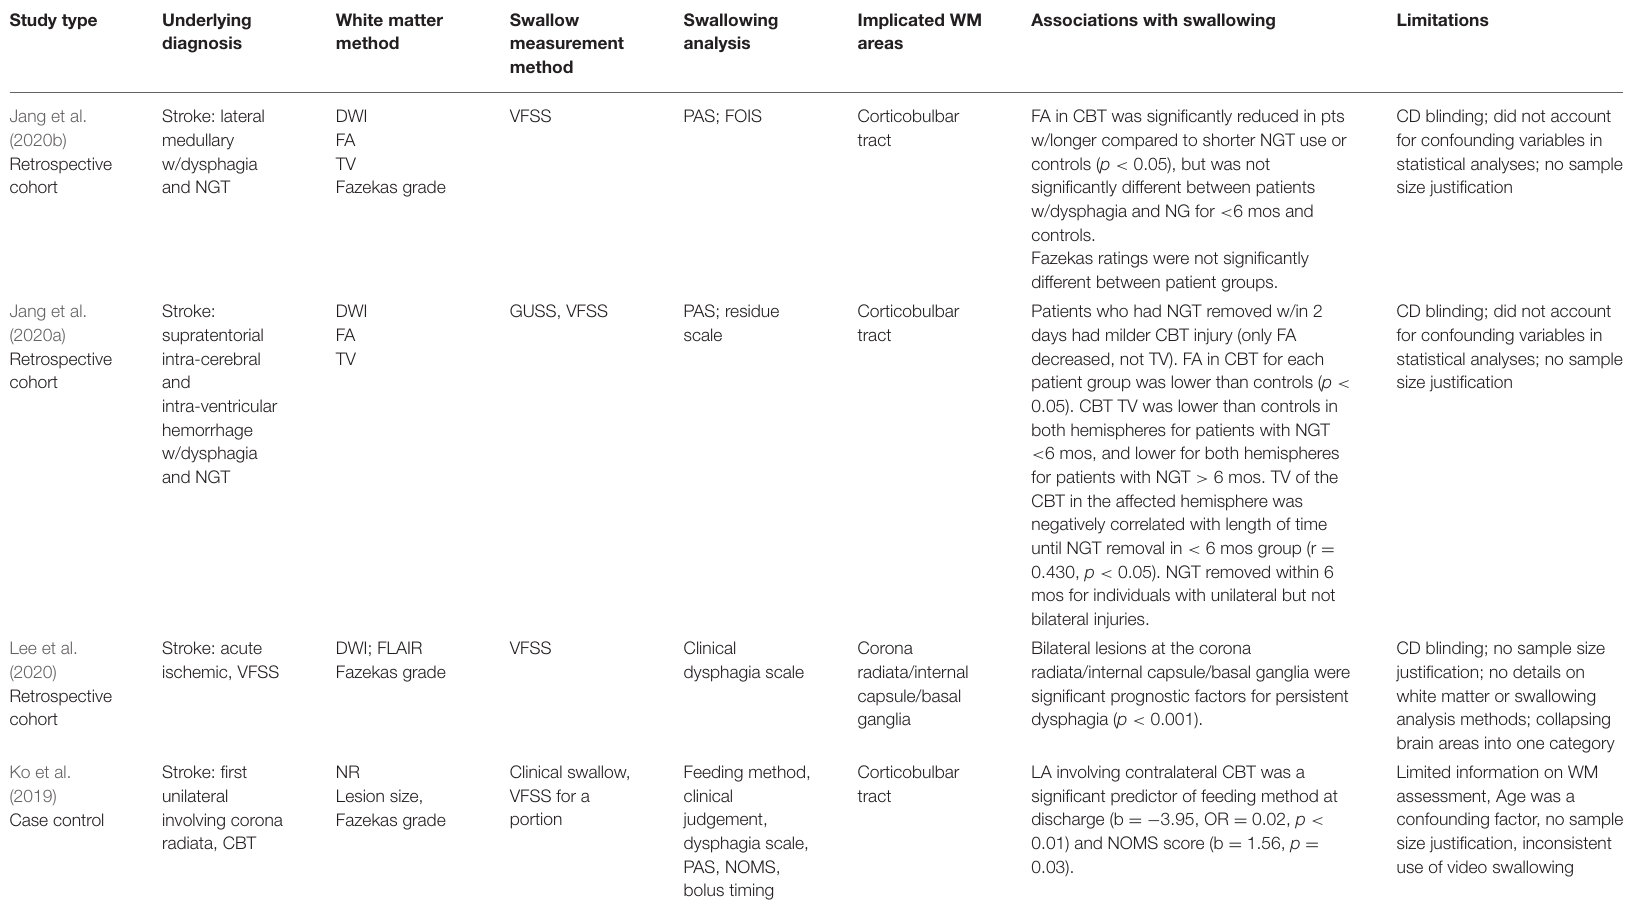
TABLE 4 | Summary of methods, major findings and limitations of studies included in qualitative synthesis ( n = 20